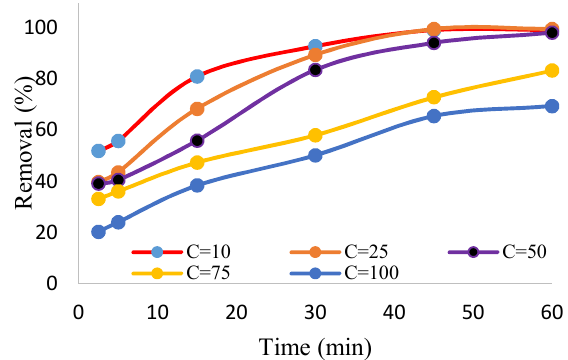
Fig. 5. Changes in the efficiency of removal of erythrosine B dye in different dye concentrations in the US/S 2 O 82- process (pH:3; concentration of persulfate, 0.003 mol/L)